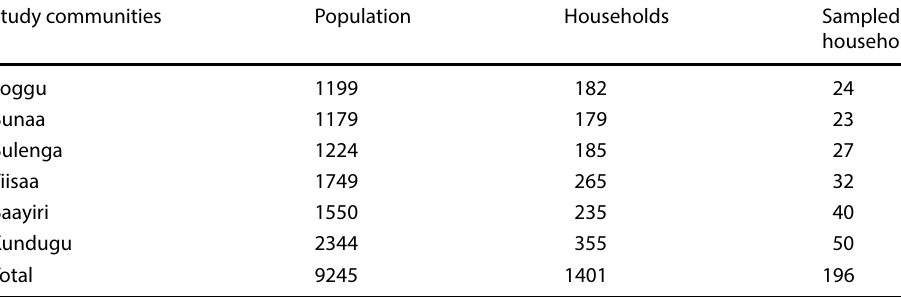
Source: Estimate data based on GSS